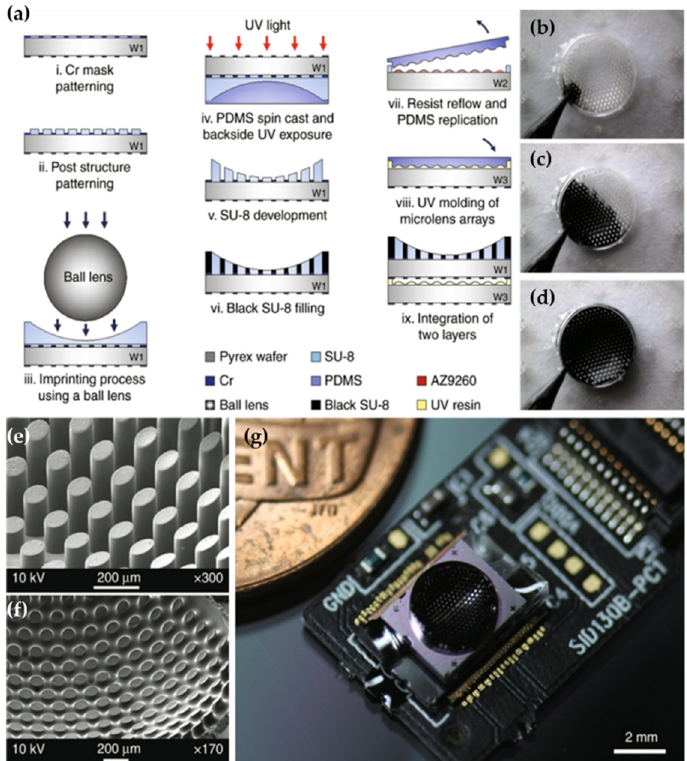
Figure 15. ( a ) The microfabrication steps of the curved MLA. ( b – d ) The optical images of 3D capillary filling of black SU-8. ( e , f ) The SEM image of concave microprism arrays before and after filling with black polymer. ( g ) The optical image of the fully assembled ultrathin digital camera. Reproduced from [51]. CC by 4.0. Table 3. The parameters and performance of the artificial compound eye with curved MLA integrated to a planar image sensor.